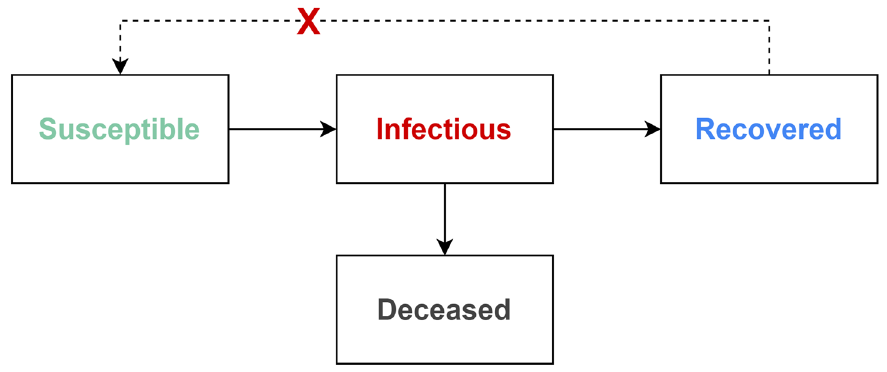
Figure 6. The concept of the SIRD